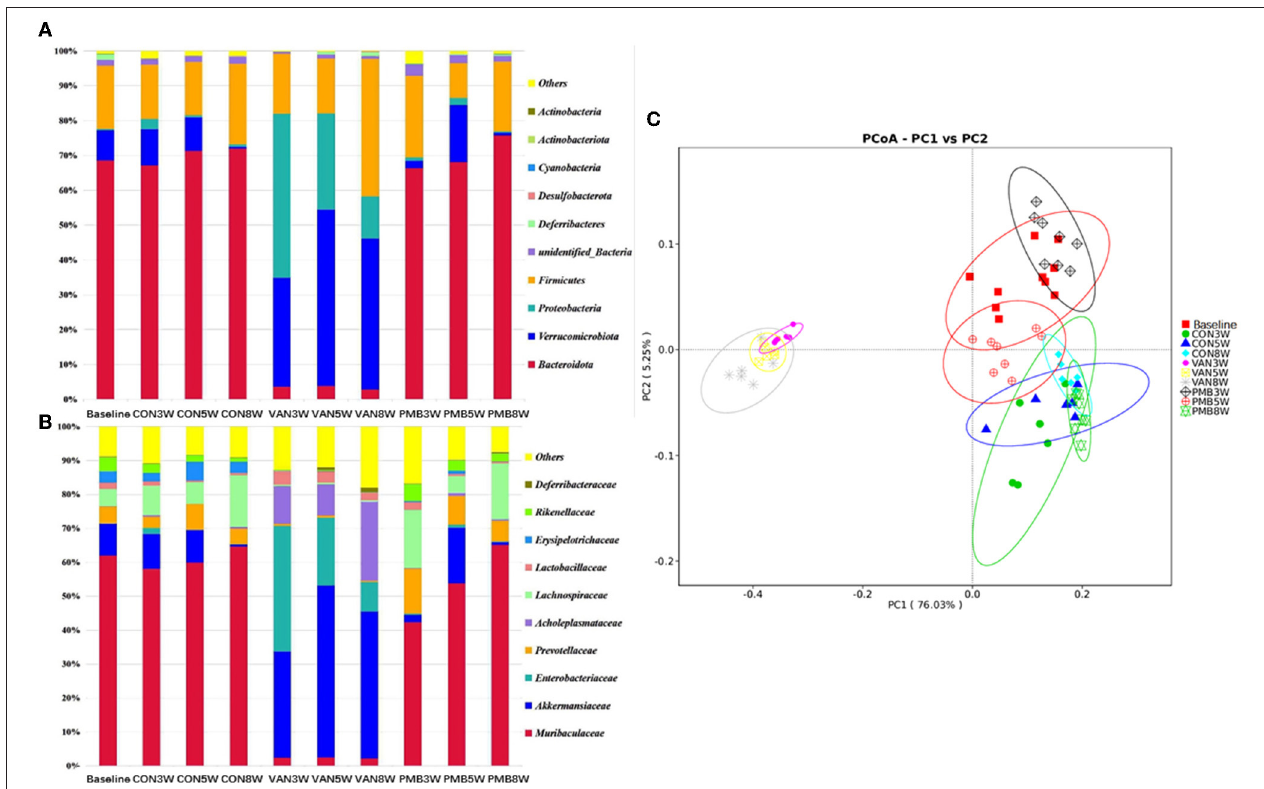
FIGURE 3 | Antibiotic-induced composition changes of gut microbiota. Distribution of the predominant bacteria with antibiotics-treated at phylum level (A) and family level (B) . (C) Principal coordinate analysis (PCoA) of fecal samples in control and antibiotic-treated groups by Curtis similarity clustering analysis. VAN, vancomycin; PMB, polymyxin B; CON,